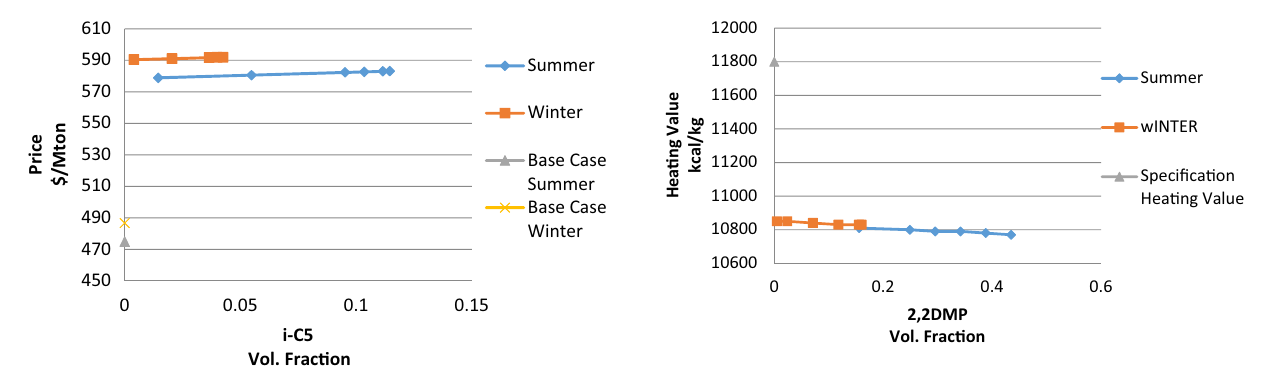
Fig. 35 Effect of adding 2,2DMP and 20 vol% DME on LPG heating